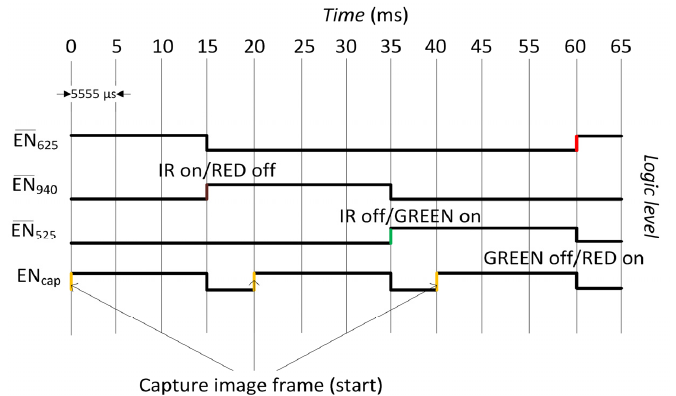
Figure 2. Timing diagram of the proposed system, rising edges of enable signals EN 525 , EN 625 , EN 940 , for LEDs with wavelength of 525 nm, 625 nm and 940 nm are highlighted with green, red and brown color. Rising edge of capture frame signal EN cap is highlighted with yellow color